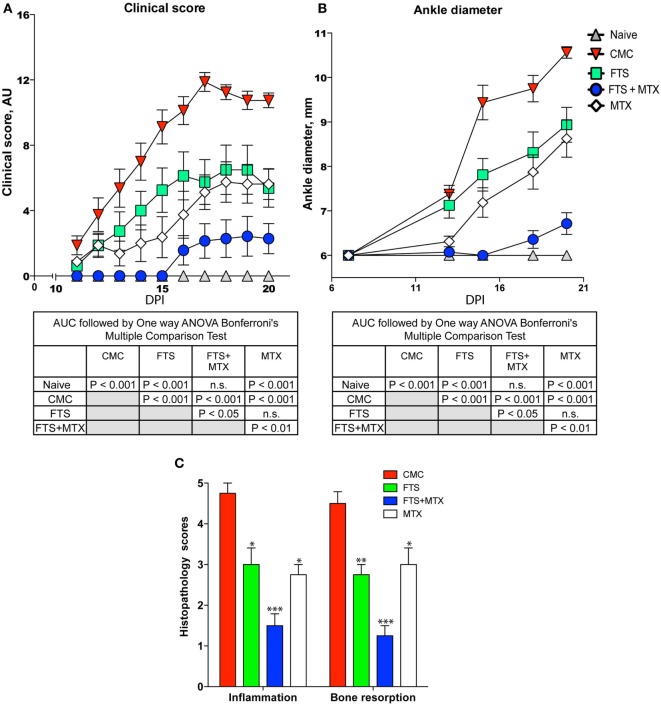
Farnesylthiosalicylic acid (FTS) treatment reduces the severity of adjuvant-induced arthritis. Rats were immunized with CFA and then graded regularly for signs of arthritis by a clinical disease severity score (A), and by caliper measurements of ankle joint diameter (B). Rats in the experimental arms were treated starting day +1 with either oral FTS (100 mg/kg), 0.5% carboxymethyl cellulose (CMC) vehicle solution, weekly i.p injection of MTX (0.5 mg/kg), or FTS combined with MTX. Statistical analysis of the AUC of the effect of the various treatments on the clinical score (A) and ankle diameter (B) was done by one way ANOVA with post hoc Bonferroni’s multiple comparison test. The results of the analysis are summarized in the table inset. One representative of three independent experiments is depicted (*P ≤ 0.05, **P ≤ 0.01, and ***P ≤ 0.001). (C) Tibiotarsal (ankle) joint tissue sections were stained with H&E for histopathological assessment, and scored on a scale of 0–5 for inflammation and bone resorption. The bar graph represents the quantification and statistical analysis of histopathology of ankles of arthritic rats in the various treatment arms. Shown bars from >3 experiments performed with n = 8 rats in each treatment arm.